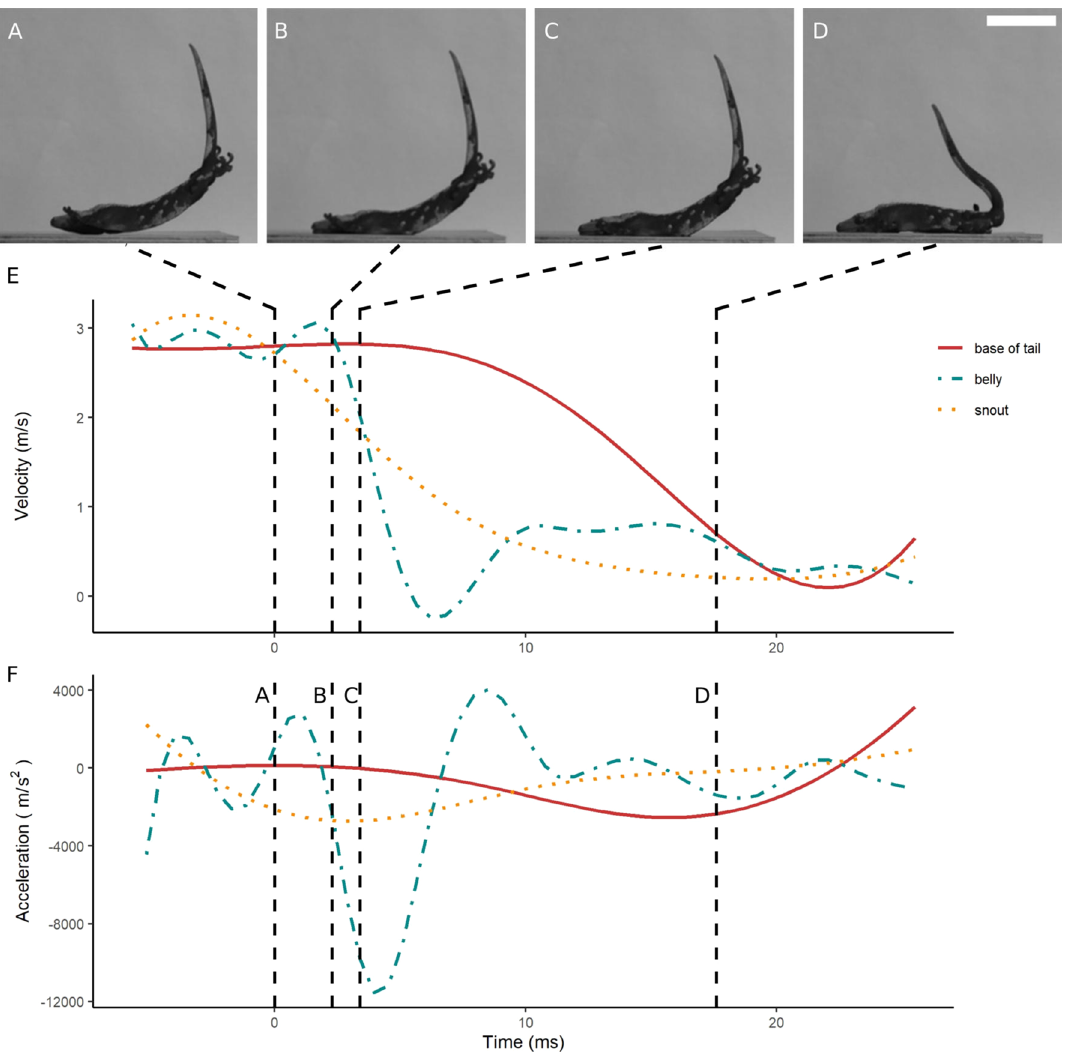
Figure 4. Representative landing process of a gecko jumping onto a horizontal platform. ( A – D ) Frames showing the belly ( A ), the snout ( B ), the forelimbs ( C ) and the hindlimbs ( D ) initiating contact with the landing platform. The time point of each frame is indicated on the plot by a vertical dashed line. ( E ) Velocity of snout (yellow dotted line), belly (blue dashed line) and base of the tail (solid red line) during landing. ( F ) Acceleration of snout, belly and base of the tail during landing. Scale bar represents 5